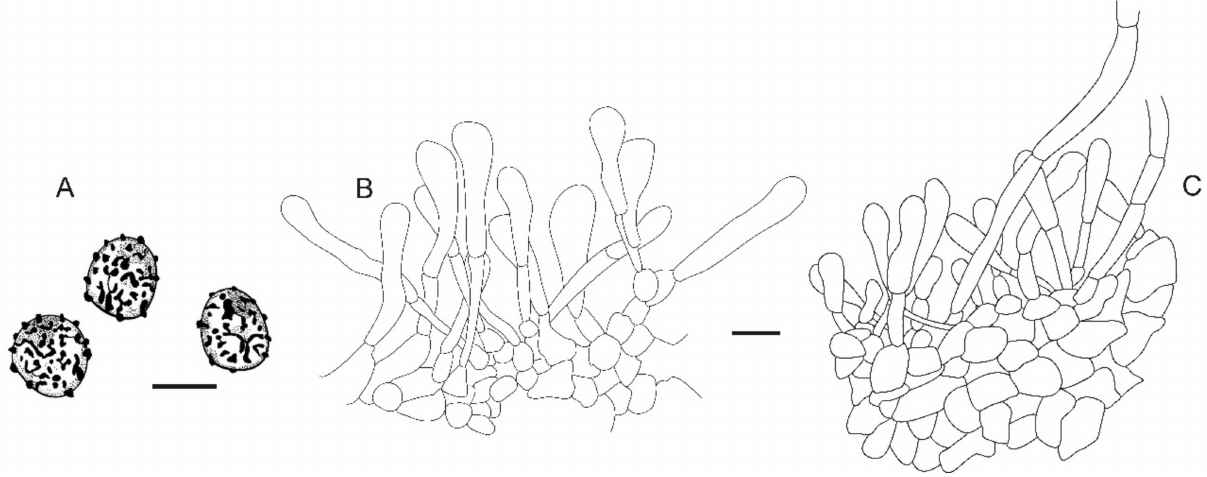
Figure 6. Microscopic features of Russula miyunensis (BJTC Z1355). ( A ) Basidiospores. ( B ) Hyphal terminations near the pileus margin. ( C ) Hyphal terminations near the pileus center. Scale bar: ( A ) = 5 µ m; ( B , C ) = 10 µ